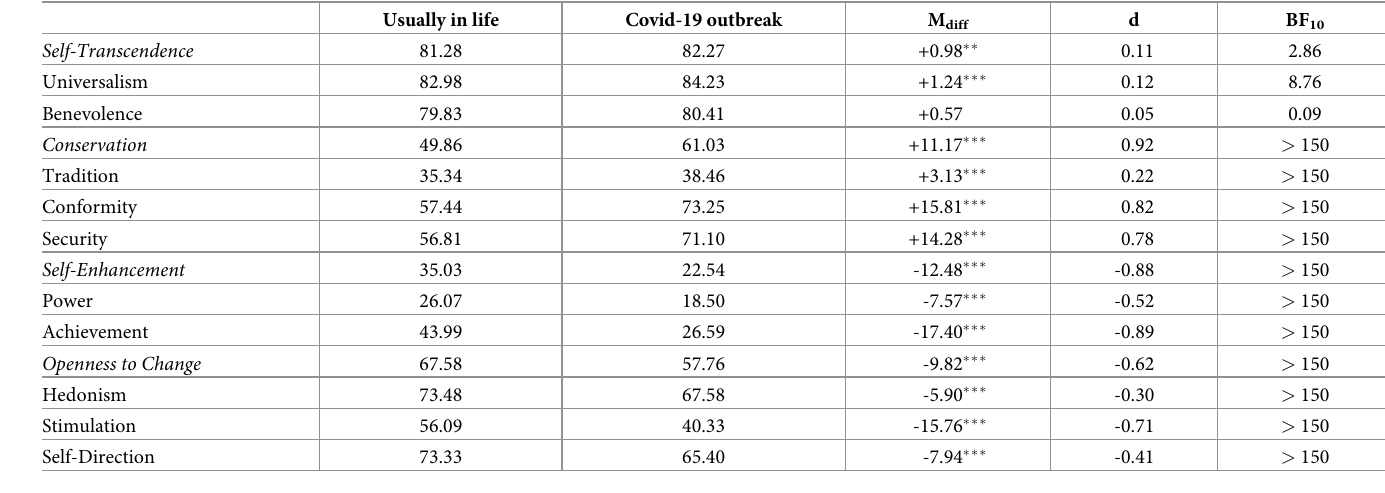
Table 2. Means, difference scores and BF 10 of Schwartz’ values according to the response context (i.e., usually in life vs. during the Covid-19 outbreak). Usually in